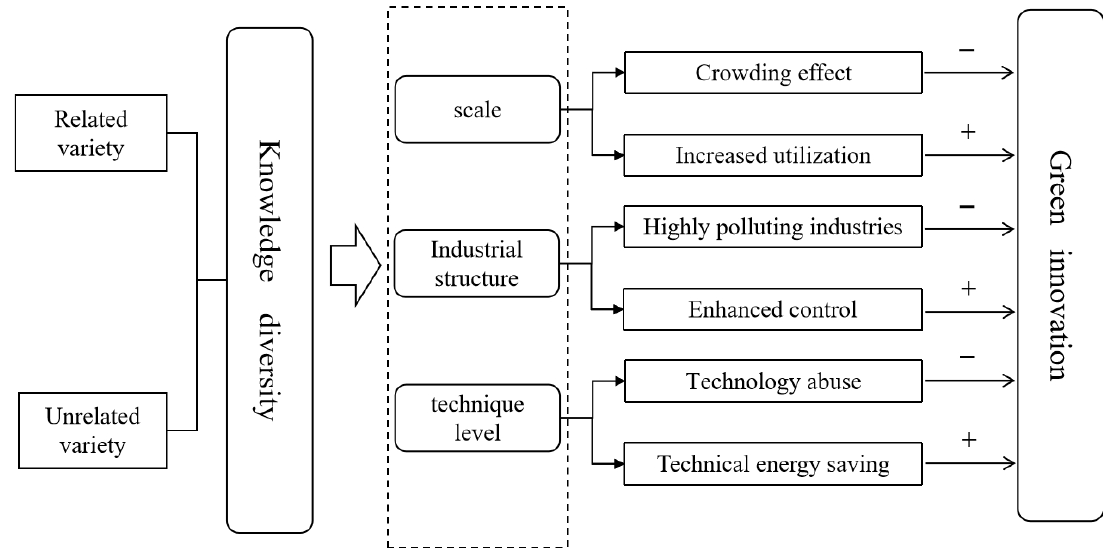
Figure 1. Research framework of the effect of knowledge diversity on green innovation.